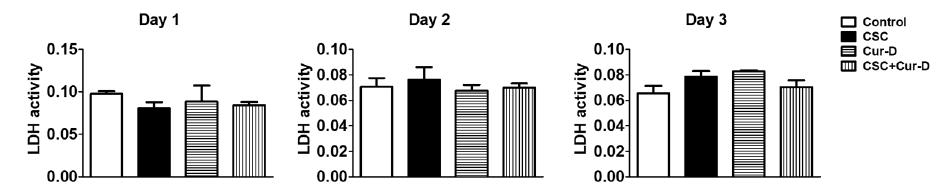
Figure 7. Toxicity of CSC and cur-D in U1 cells after crossing the in vitro blood–brain barrier (BBB) model: To determine the toxicity of CSC and Cur-D across the BBB, we used U1 cells to create a modified in vitro BBB model in a Transwell ® plate, as described in the methodology. The upper inserts containing endothelial cells were exposed to a single dose of Control (DMSO), CSC (40 µg/mL), and Cur-D (0.4 µM), and toxicity from differentiated U1 macrophages present in the lower wells were measured every day for 3 days, using an LDH assay kit from the culture media of the bottom chamber. One-way ANOVA with Tukey’s post-hoc test was applied to compare between multiple groups